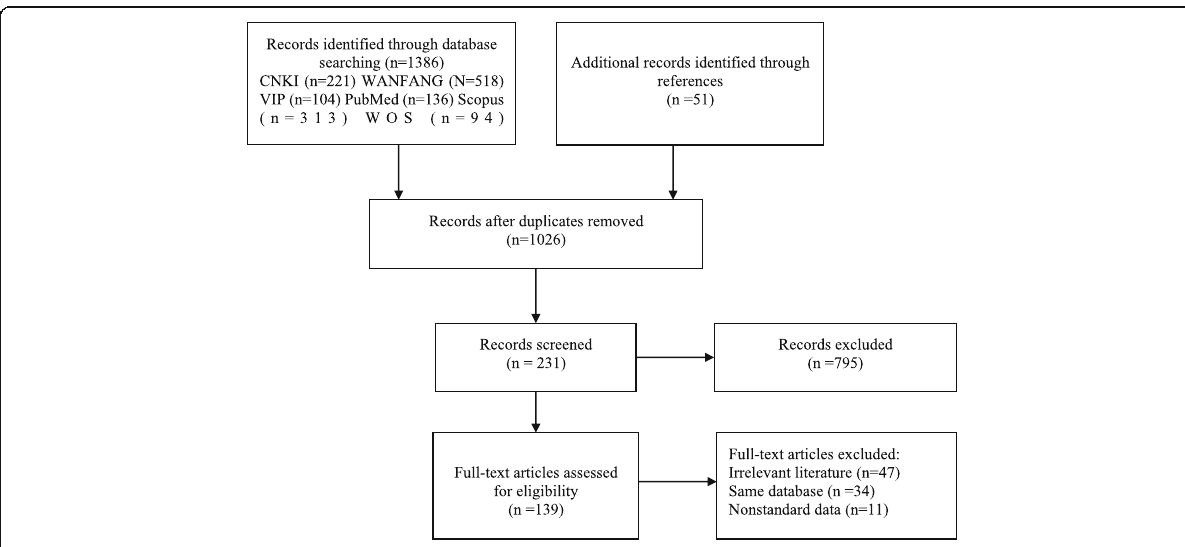
Fig. 1 Flow diagram for selection of publications for quantitative synthesis,